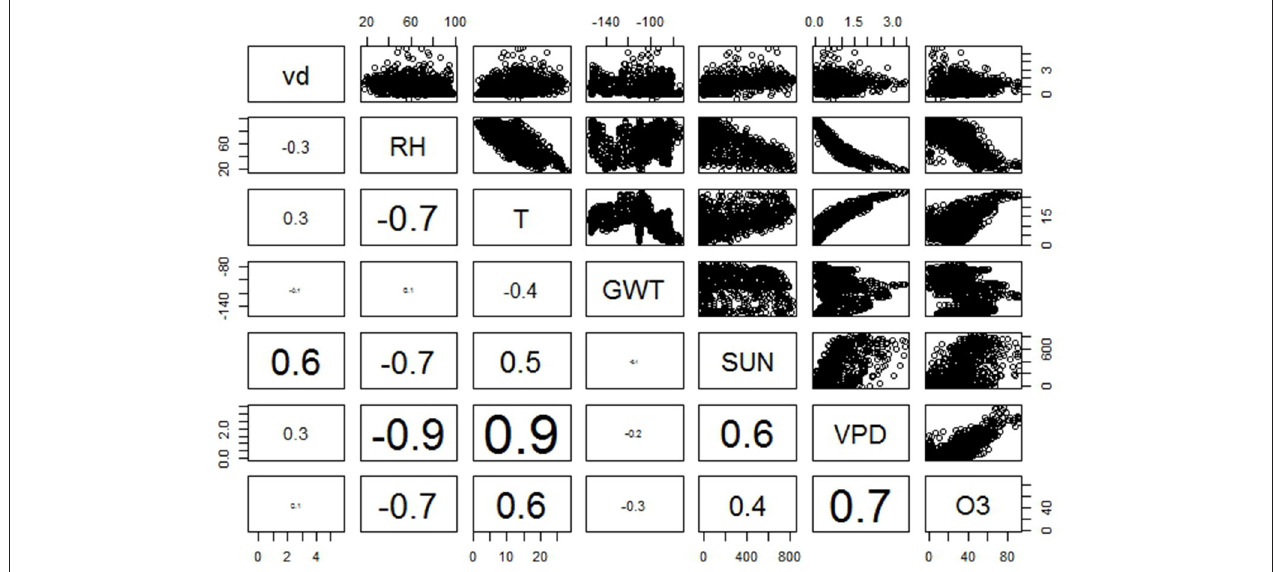
FIGURE 10 | Pairplot of half-hourly deposition velocity ( υ d ,cm s − 1 ) and covariates measured over the period 20 March to 9 May 2007. The upper panel contains scatterplots while the lower panel depicts the estimated pair-wise Pearson correlations using a font size which is proportional to the absolute value of the estimated correlation coefficient.